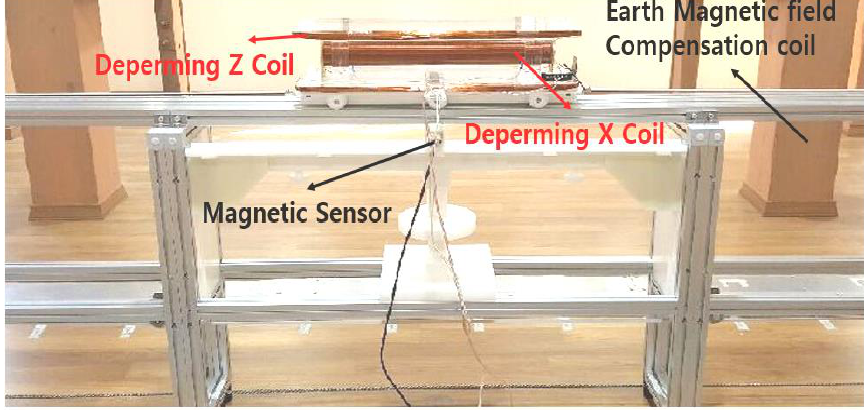
Figure 12. Sensing system for deperming.